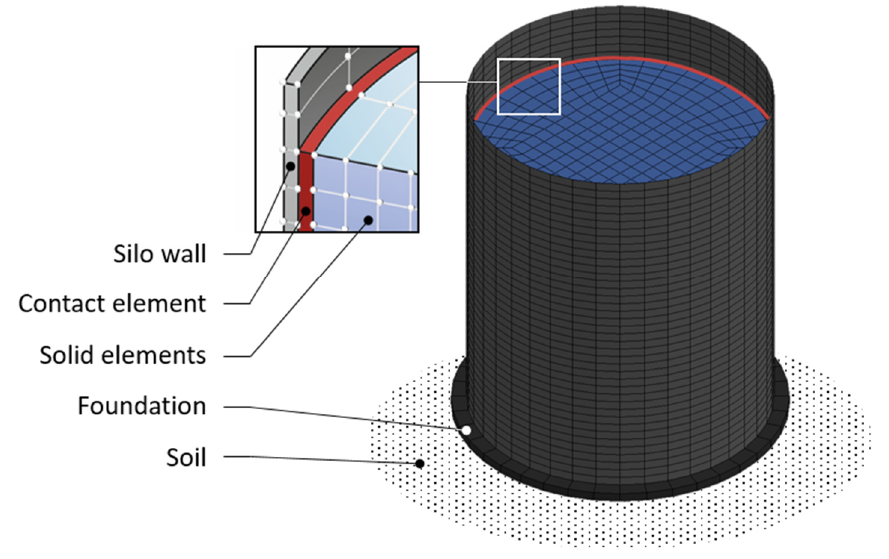
Figure 4. Nonlinear calculation model.